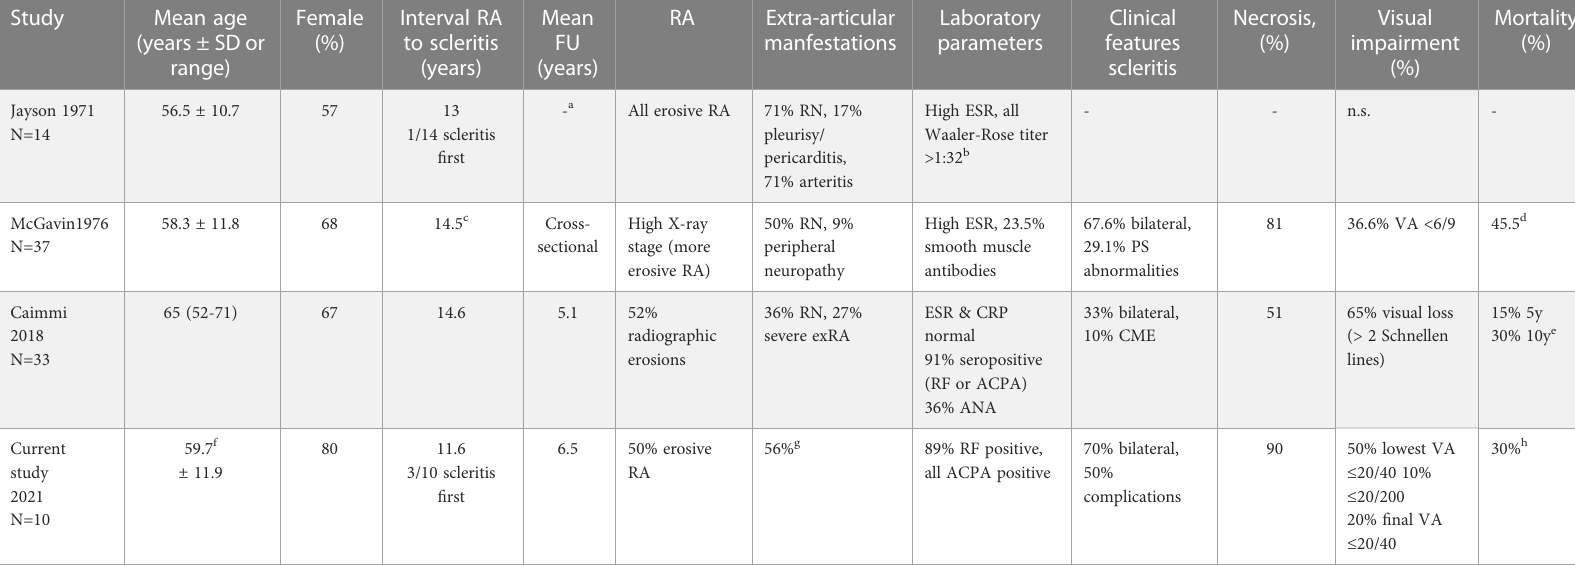
TABLE 2 Characteristics, risk factors and complications of scleritis in rheumatoid arthritis patients over time.